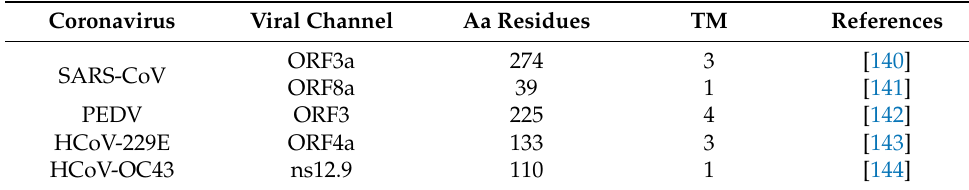
Table 1. Accessory proteins of coronaviruses that function as ion channel proteins. Coronavirus Viral Channel Aa Residues